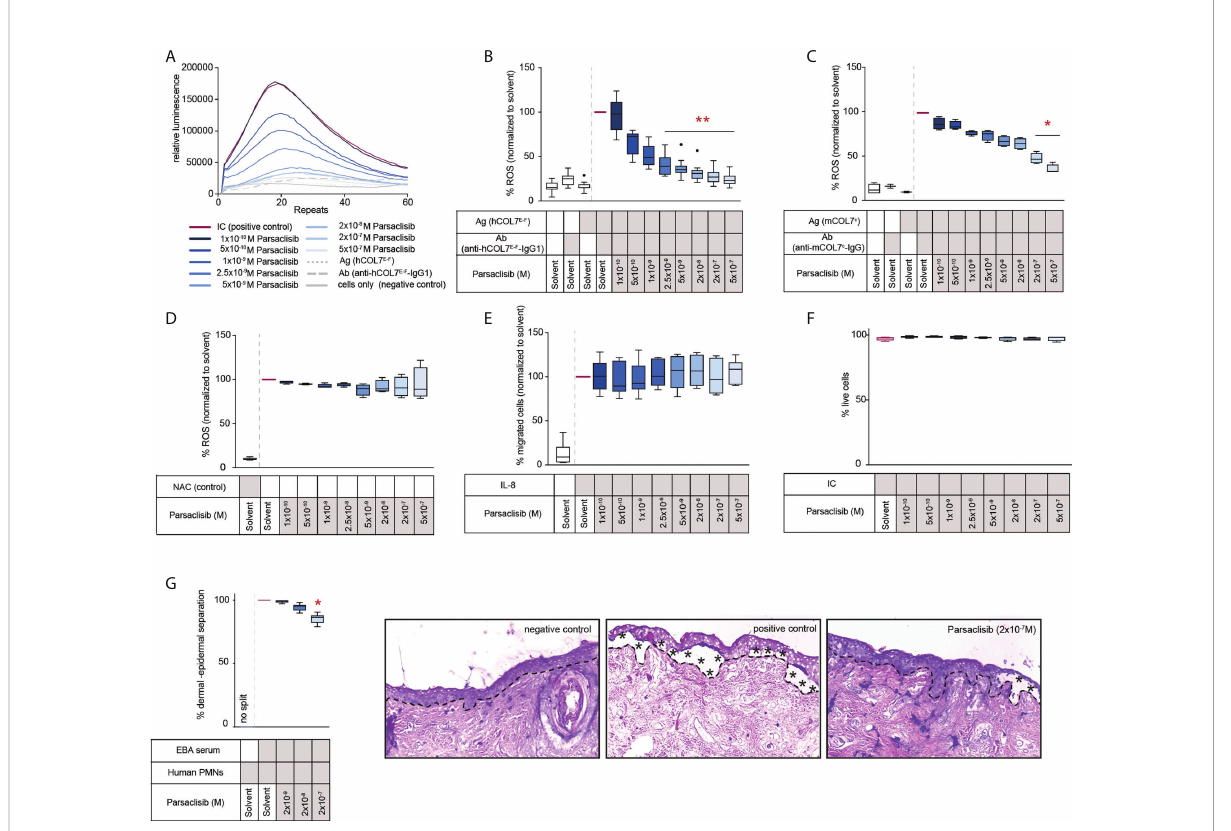
FIGURE 2 Parsaclisib impairs immune complex-induced neutrophil activation in vitro . Human polymorphonuclear leukocytes (PMNs) were isolated from healthy blood donors and activated by immobilized immune complexes (IC) consisting of recombinant human COL7 (hCOL7E-F) and anti- hCOL7E-F IgG1 in the presence or absence of parsaclisib at an 8-fold concentration range. Relative reactive oxygen species (ROS) release was detected by a luminescence-based assay. (A) Representative example of one donor showing the relative luminescence after IC-stimulation over the time. (B) Area under the curve (AUC, cumulative values) of luminescence, n=12. (C) PMNs were isolated from murine femurs and activated using immobilized ICs consisting of recombinant murine COL7 (mCOL7 C ) and anti-mCOL7 C -IgG in the presence or absence of parsaclisib, n=4. (D) ROS were generated enzymatically by myeloperoxidase, catalase, and glucose oxidase, n=4. The ROS scavenger N-acetylcysteine (NAC) was used as assay control. (E) Chemotaxis of freshly isolated PMNs was induced by IL-8 in the presence of parsaclisib using a Boyden chamber assay. The attracted cell number during a time period of 60 minutes is shown as AUC. (F) Human PMNs were stimulated with immobilized ICs in the presence/absence of parsaclisib. To exclude toxicity, the amount of propidium iodide (PI)- and Annexin V-positive cells after IC stimulation was identi fi ed. (G) Cryosections of human skin were incubated with IgG isolated from EBA patients, followed by the addition of PMNs, isolated from healthy donors (cryosection assay). Split formation along the dermal epidermal junction (DEJ, dotted line) was analyzed as percentage of the whole DEJ. Asterisks indicate split formation. (A-F) Data was normalized to positive control (either IC- or IL-8-stimulated PMNs). Solvent control was always added to positive and negative controls. (B-G) Data are shown as Tukey ’ s box-and-whisker plots. ANOVA on ranks (Kruskal- Wallis) was applied followed by a Dunn´s multiple comparison test, (B) n=12, (C) n=2-4, (D, F) n=4, (E) n=5, (G) n=6 (for detailed information see attached raw data table), *p<0.05,